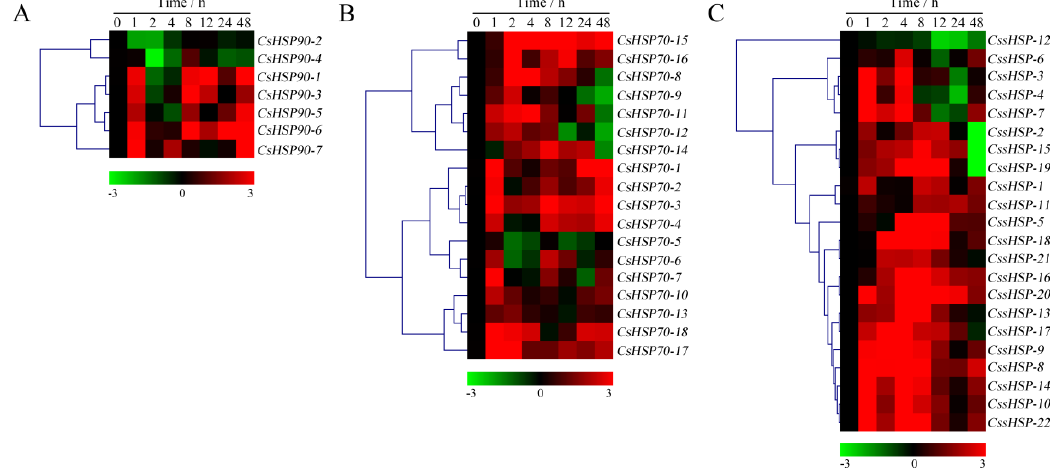
Figure 8. Expression profiles of CsHSP90 ( A ), CsHSP70 ( B ), and CssHSP ( C ) genes in tea plant under drought stress (20% polyethylene glycol (PEG) 6000). The heatmap was generated by MeV software using the CsHSP genes expression data, and normalized log 2 transformed values were used with hierarchical clustering. The red and green colors indicate higher or lower transcript abundances than those of the relevant control, respectively.